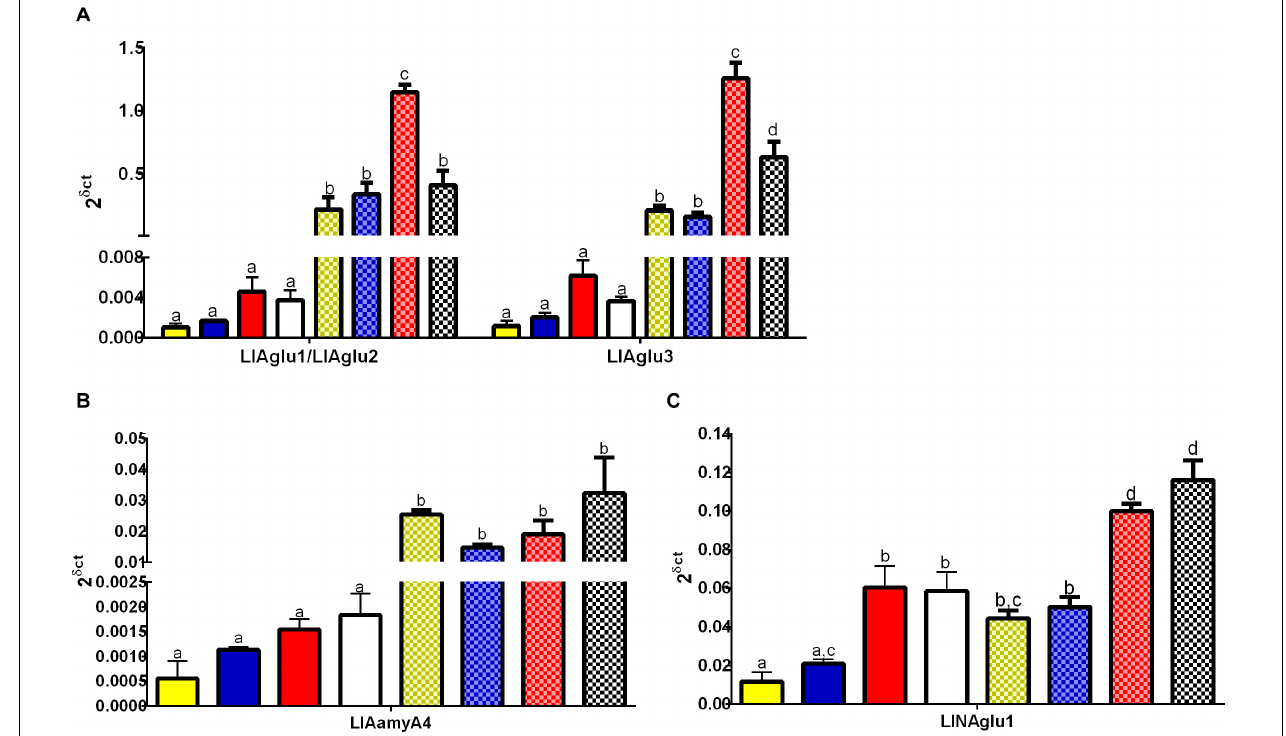
FIGURE 5 | Expression pattern of genes belonging to the GH13 and GH31 in L. longipalpis by qRT-PCR (2 δ ct ). Expression was analyzed in different tissues for adult females submitted to different physiological conditions. The expression levels of genes belonging to GH13 were analyzed for (A) α -glucosidases (LlAglu1/LlAglu2 and LlAgGlu3), and (B) α -amylase (LlAamyA4). For the GH31, the expression patterns were analyzed for (C) neutral α -glucosidase (LlNAglu1). Samples of the rest of the body (plain bars) and gut (dotted bars) were analyzed, for each physiological condition tested: newly hatched females (yellow bars), females fed on 1.2 M sucrose for 48 h (blue bars), females at 48 h after blood-feeding (red bars), and females at 48 h after infection with L. mexicana (white bars). Results were the mean ± SEM of three biological replicates. Each replicate included two cDNA samples for each condition tested. cDNA samples were obtained from a pool of 10 sand flies (gut or rest of the body). One-way ANOVA, followed by Tukey multiple comparison tests. In the subset of results for each gene, bars with the same letters are not statistically different to each other, p >